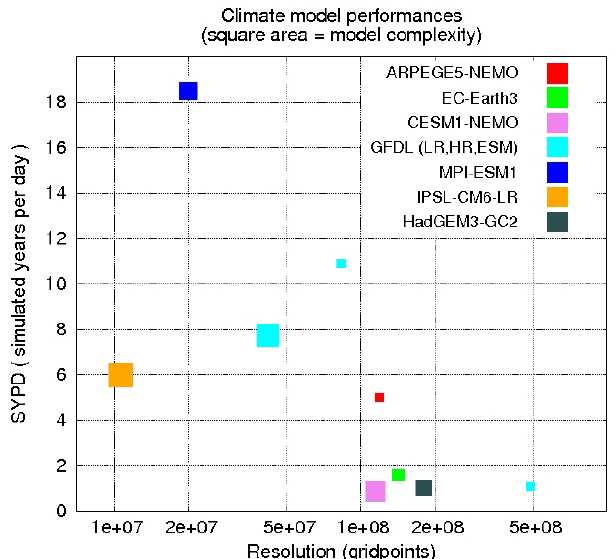
Figure 4. Performance, resolution, and complexity for a subset of ESMs from Table 1, in throughput